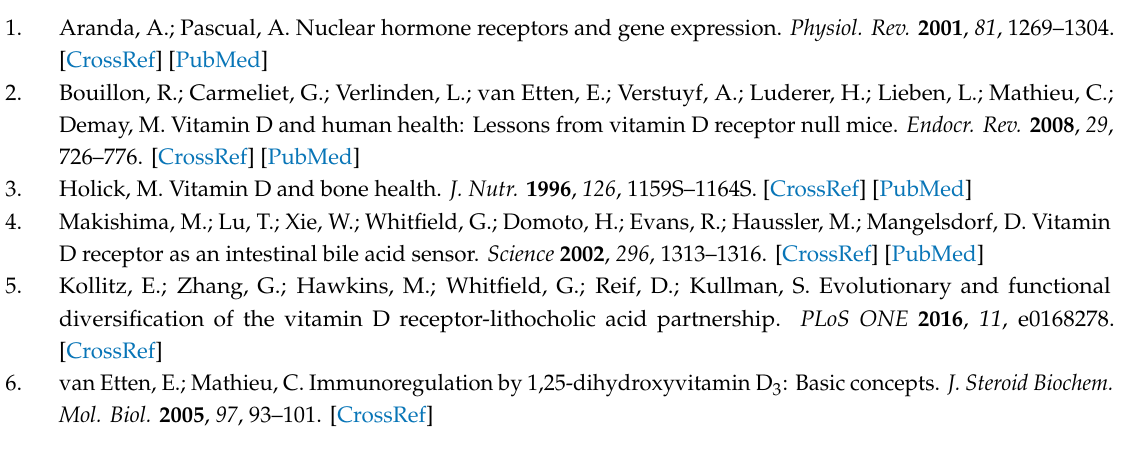
Figure S1: Methylation pattern of Vdr gene promoter in murine blood cells. Figure S2: Methylation pattern of VDR gene promoter regions in human normal blood and leukemic cells. Figure S3: E ff ects of hypomethylating agents towards 1,25D-induced CD14 expression on HL60 cells. Figure S4: E ff ects of hypomethylating agents to viability of HL60 cells. Figure S5: Methylation pattern of VDR gene promoter 1c region in HL60 cells exposed to hypomethylating